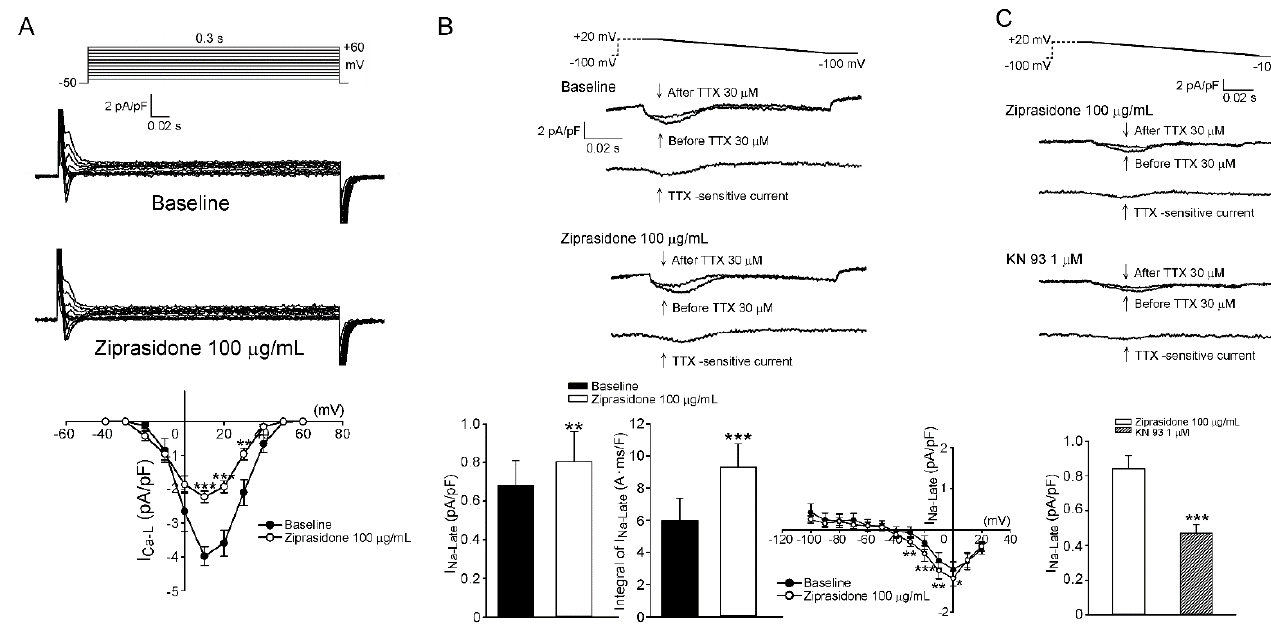
Figure 3. I Ca,L and I Na,L . ( A ): (top and middle section) Representative traces of I Ca,L in atrial myocytes with or without ziprasidone and (bottom section) the I–V relationship ( n = 9/3; ** p < 0.01; *** p < 0.005). ( B ): (top and middle section) Representative traces of I Na,L (TTX-sensitive current) in atrial myocytes with or without ziprasidone, and (bottom section) the mean data of I Na,L and the integral of I Na,L and the IV relationship ( n = 9/3; * p < 0.05; ** p < 0.01). ( C ): (top and middle section) Representative traces of I Na,L in ziprasidone-treated atrial myocytes with or without KN-93, and (bottom section) the mean data ( n = 13/3; *** p < 0.005 ).